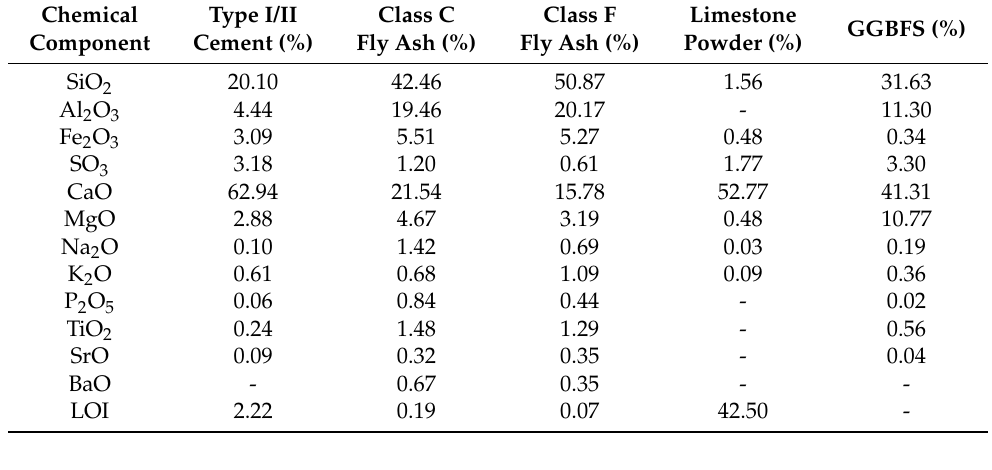
Table 1. Chemical composition of cement, SCMs, and filler.